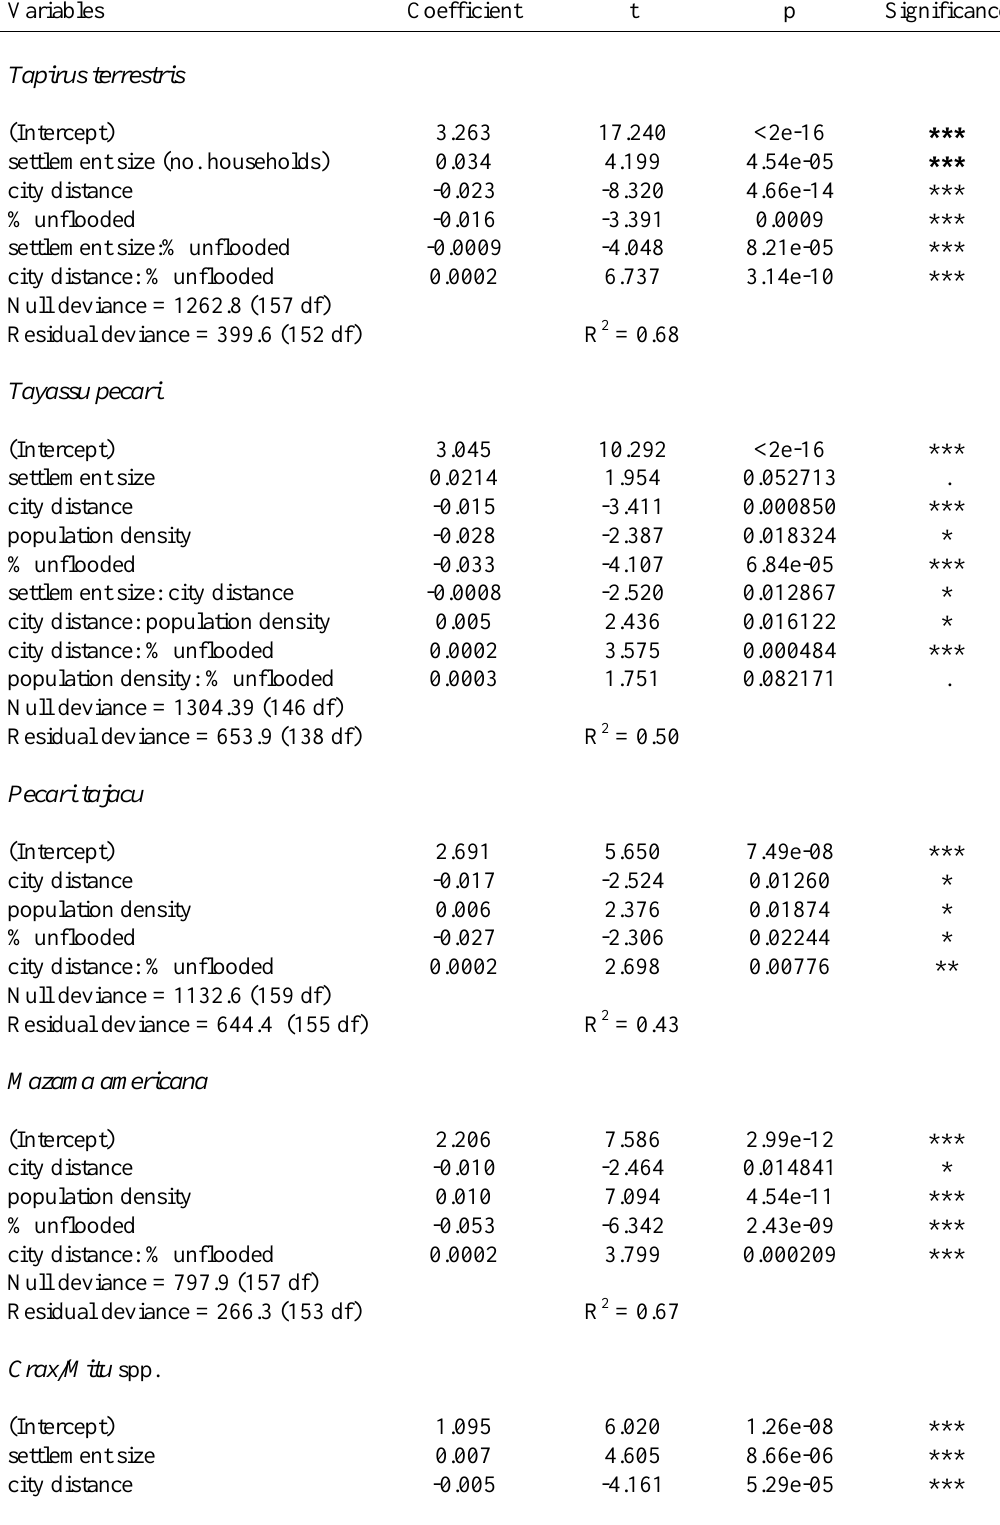
Table A3. Results of minimal Generalized Linear Models of settlement-scale faunal depletion distances. These results were used to predict depletion distances around non- visited communities along seven rivers in Amazonas State, Brazil. A quasi-poisson error structure was specified. Significance levels refer to: p < 0.1 (.); p < 0.05 (*); p < 0.01 (**); p < 0.001